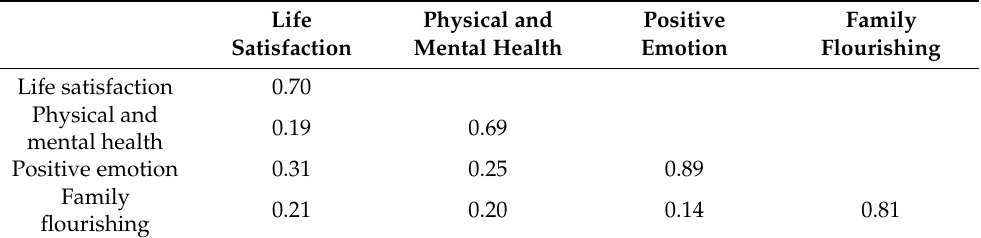
Table 7. Discriminant Validity.